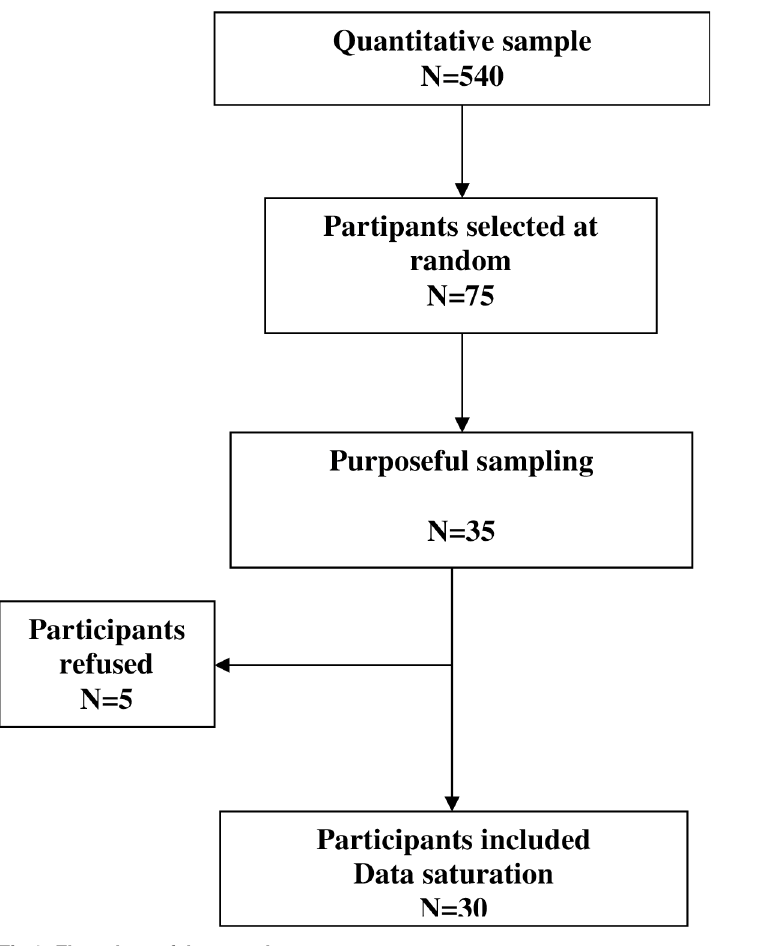
Fig 1. Flow chart of the